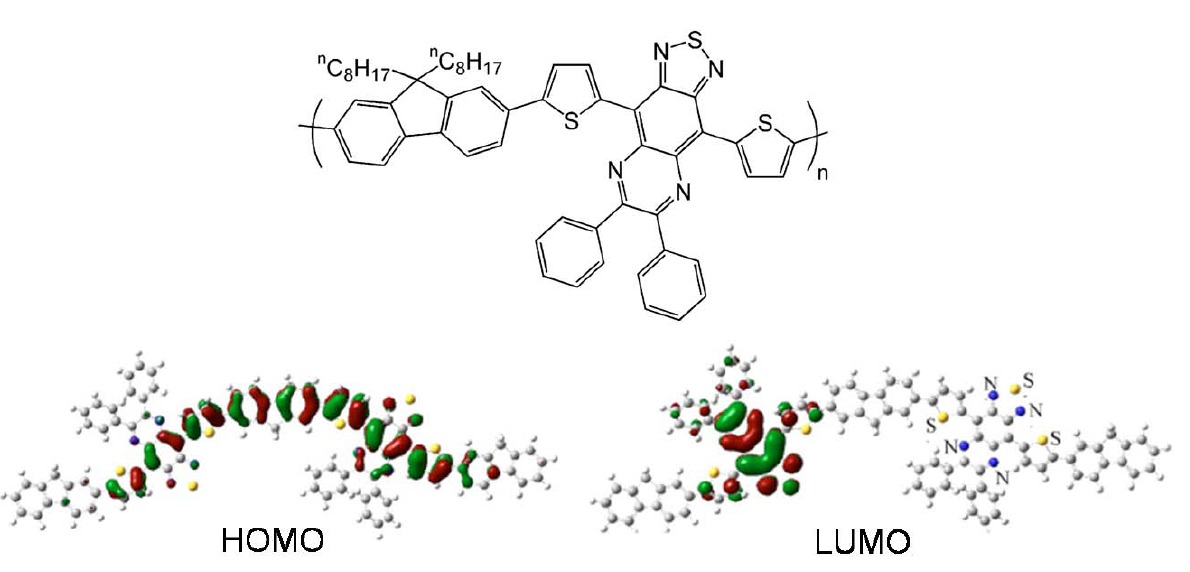
Figure 13. Chemical structure and frontier molecular orbitals topologies of semiconducting copolymer AFPO-Green1 . Reproduced with permission from reference 69. Copyright 2005 American Institute of